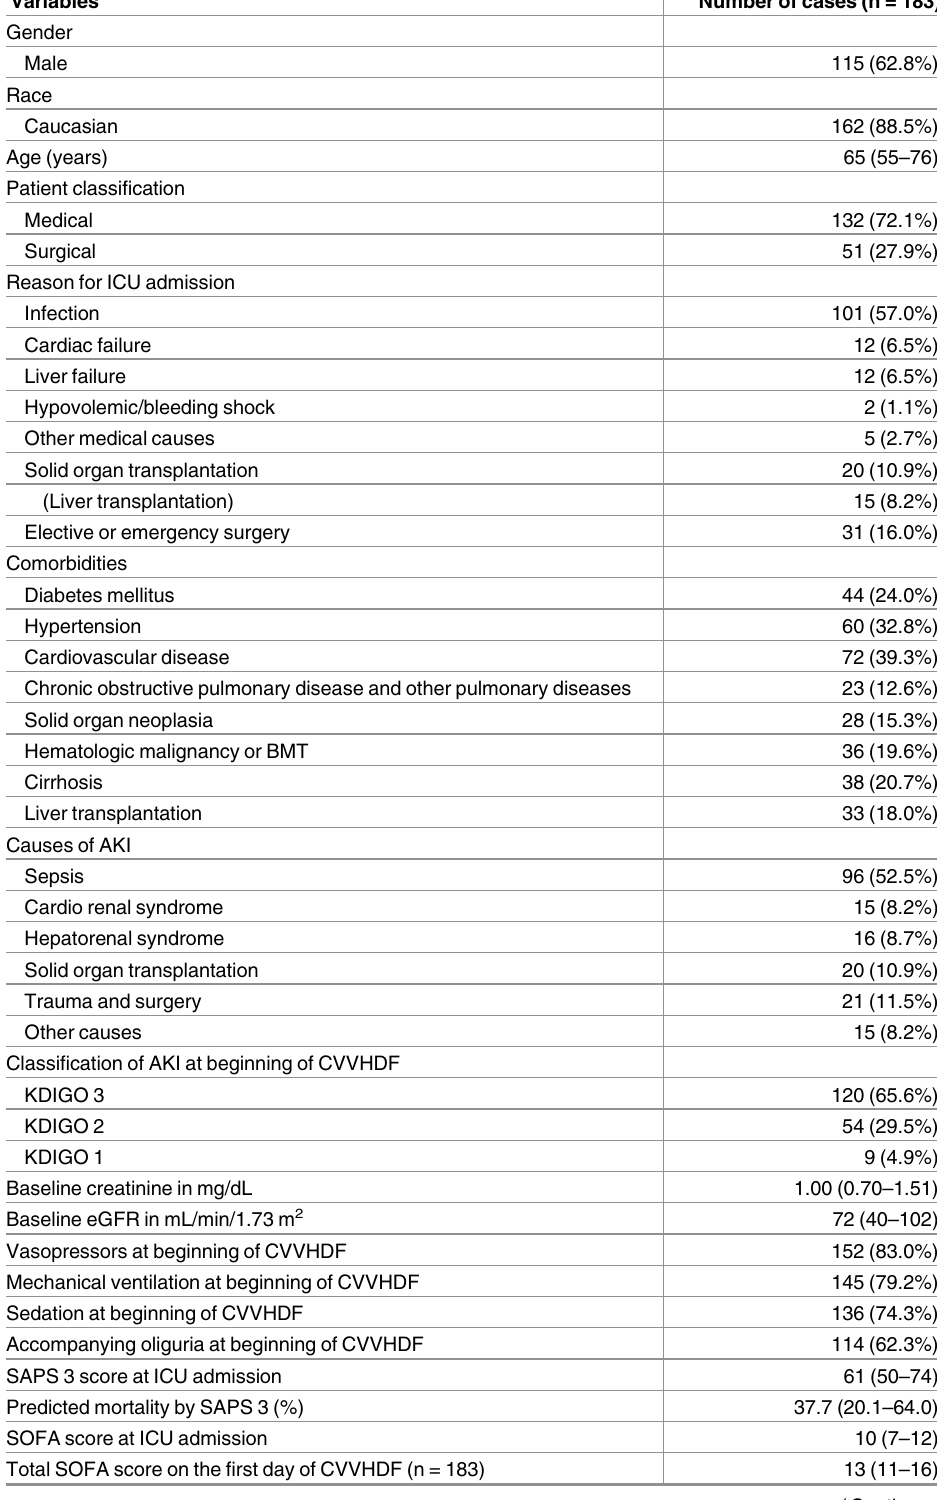
Table 1. Description of the main clinical and demographic